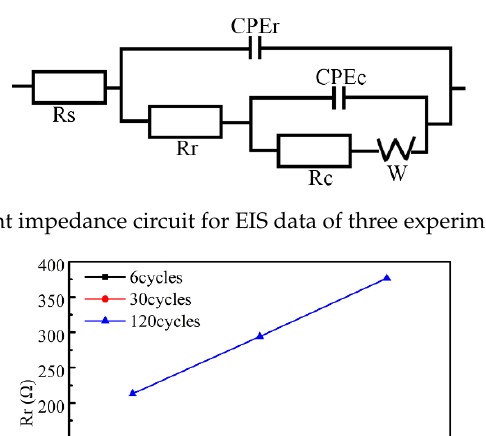
Figure 9. Equivalent impedance circuit for EIS data of three experimental steel groups.